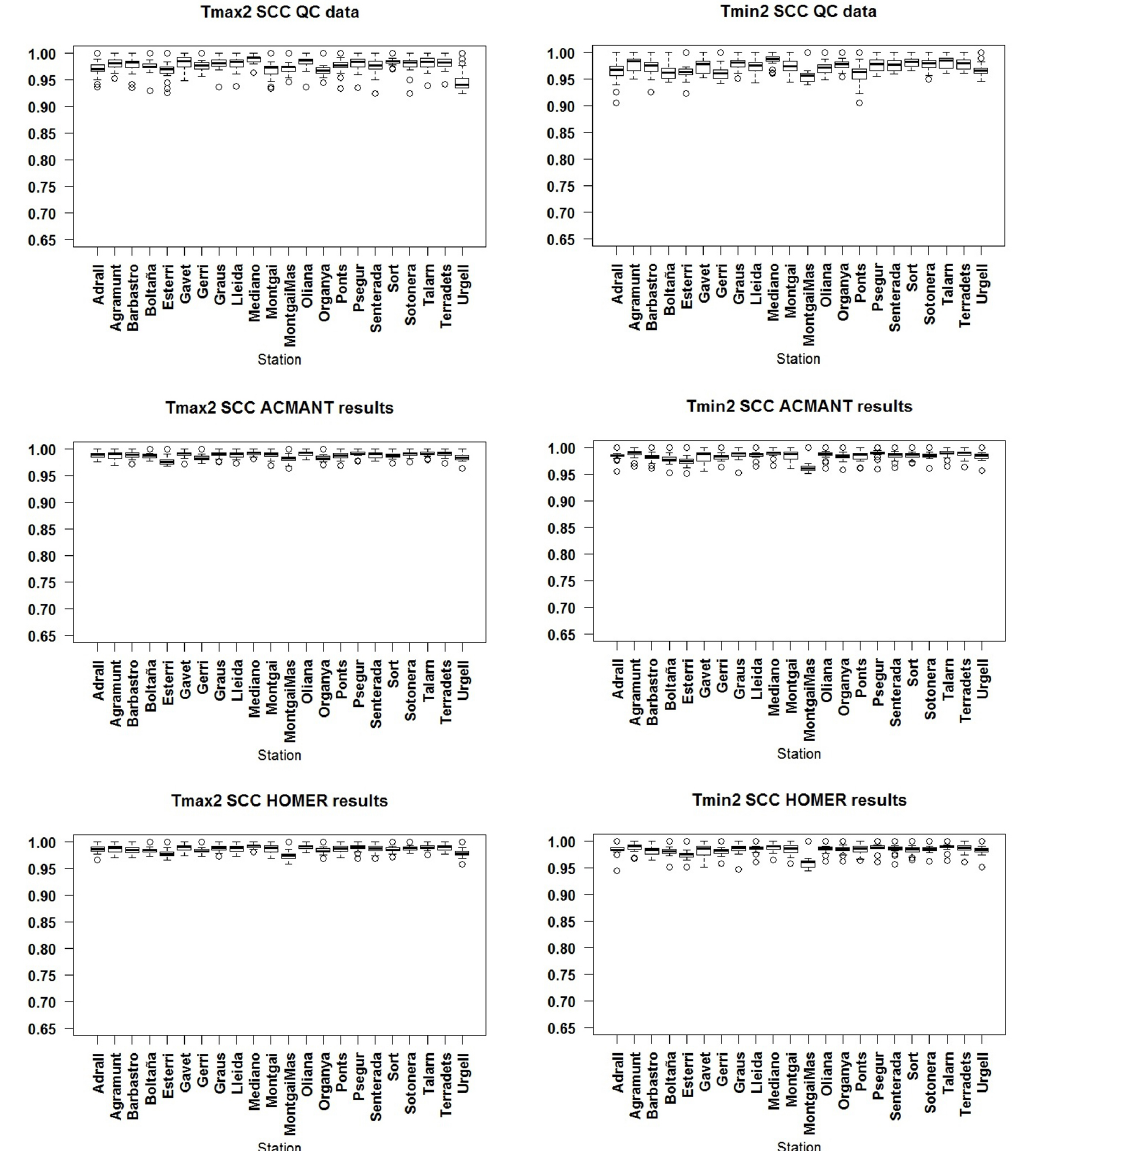
Figure 6. Boxplots of Spearman Correlation Coefficients of QC data (top panels), ACMANT (middle panels) and HOMER (bottom panels) homogenized data for maximum (left panels) and minimum (right panels) temperature for stations in cluster